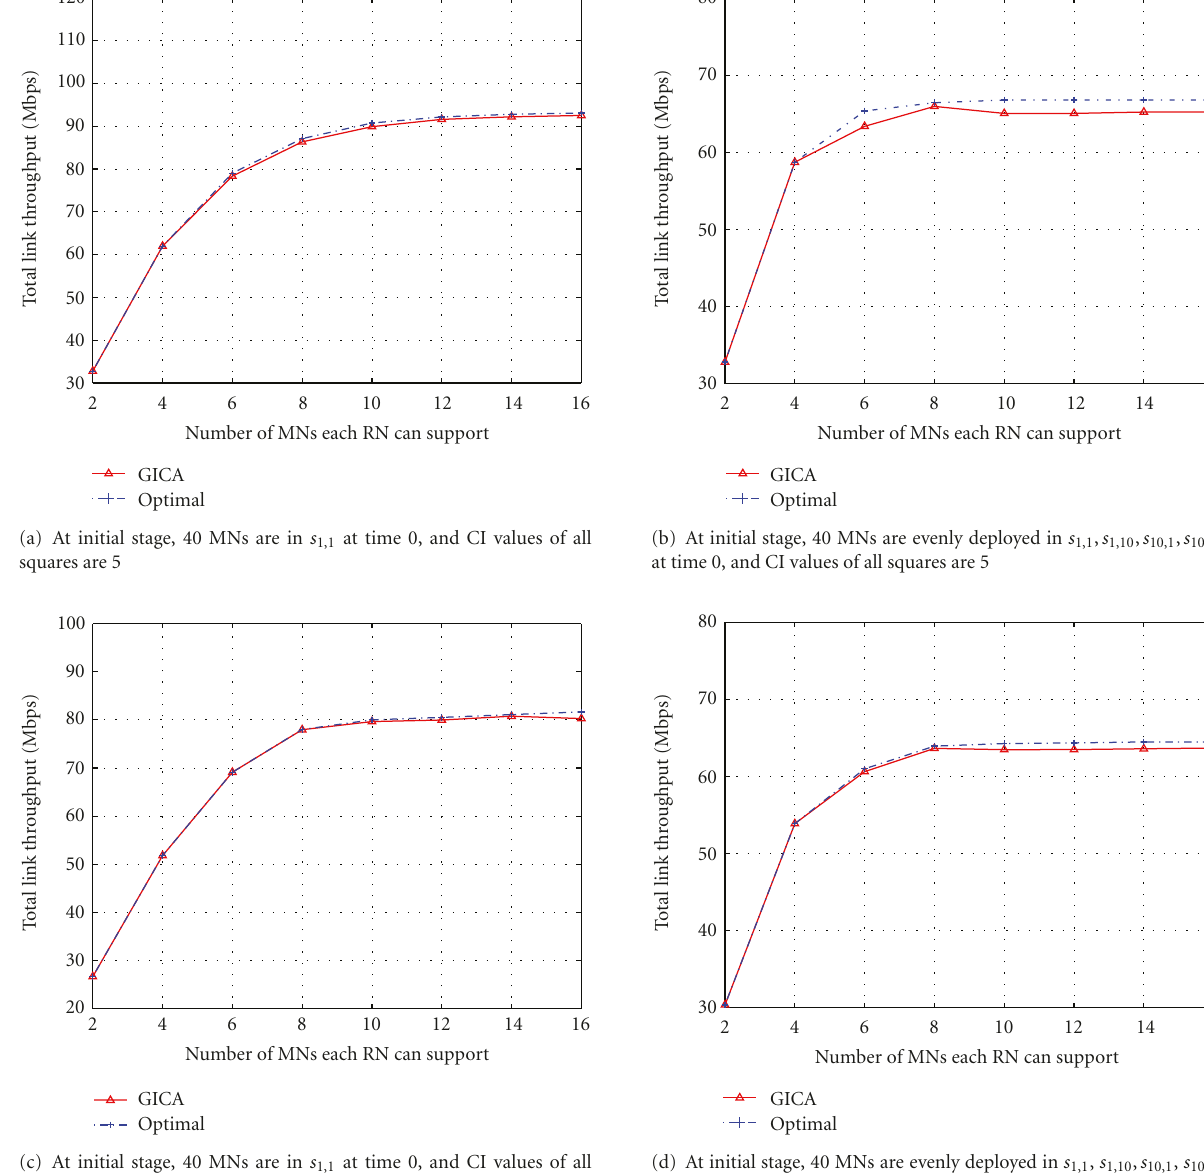
a set Y , Z denotes the minimum cardinality of the set U (cid:12) such that U (cid:12) ⊂ U and ∪ u ∈ U (cid:12) u = Y . To obtain an